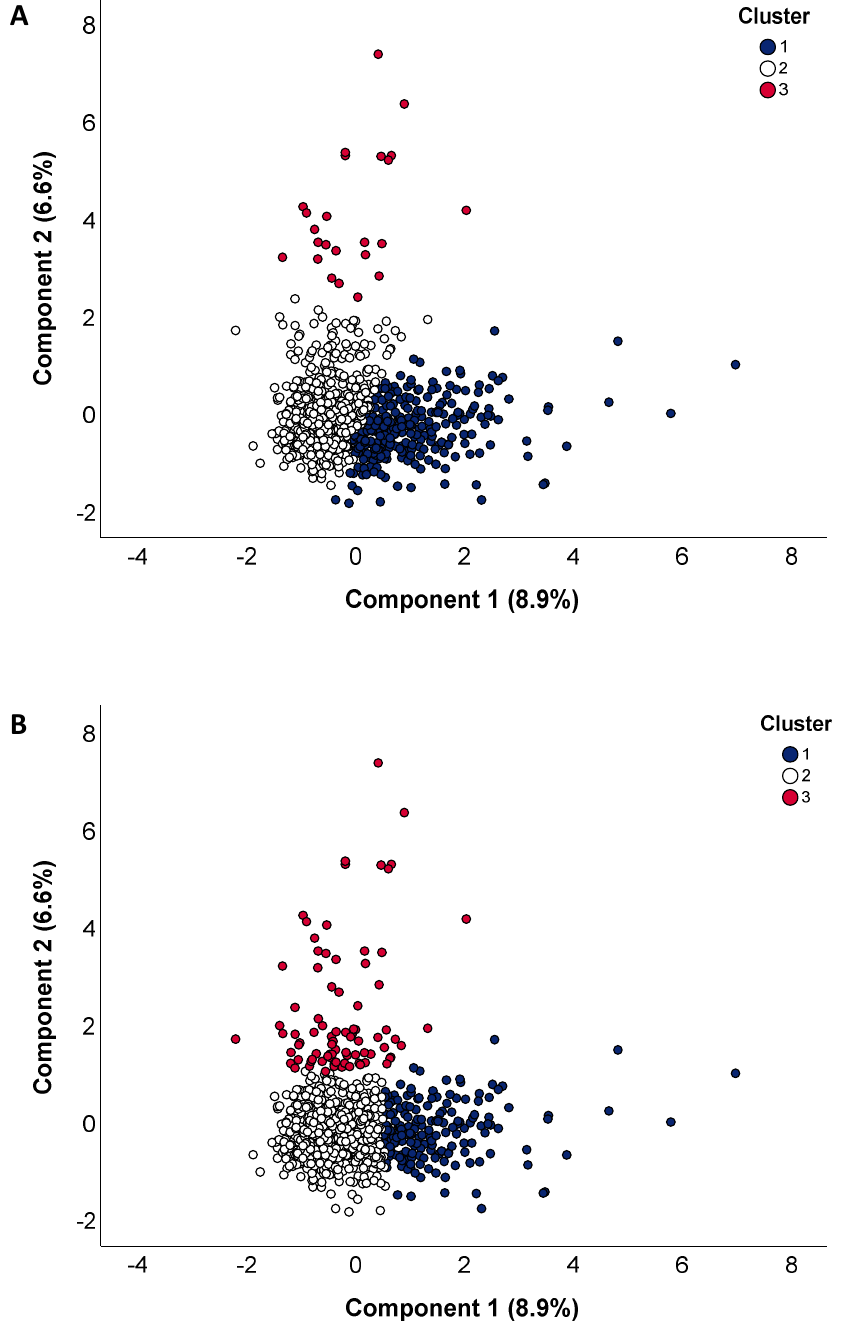
Figure 3. Outputs of the clustering of principal components. The score plots show the relationship between principal components 1 and 2, in which participants were assigned to 3 different clusters based on hierarchical clustering ( A ) and K-means clustering ( B ).